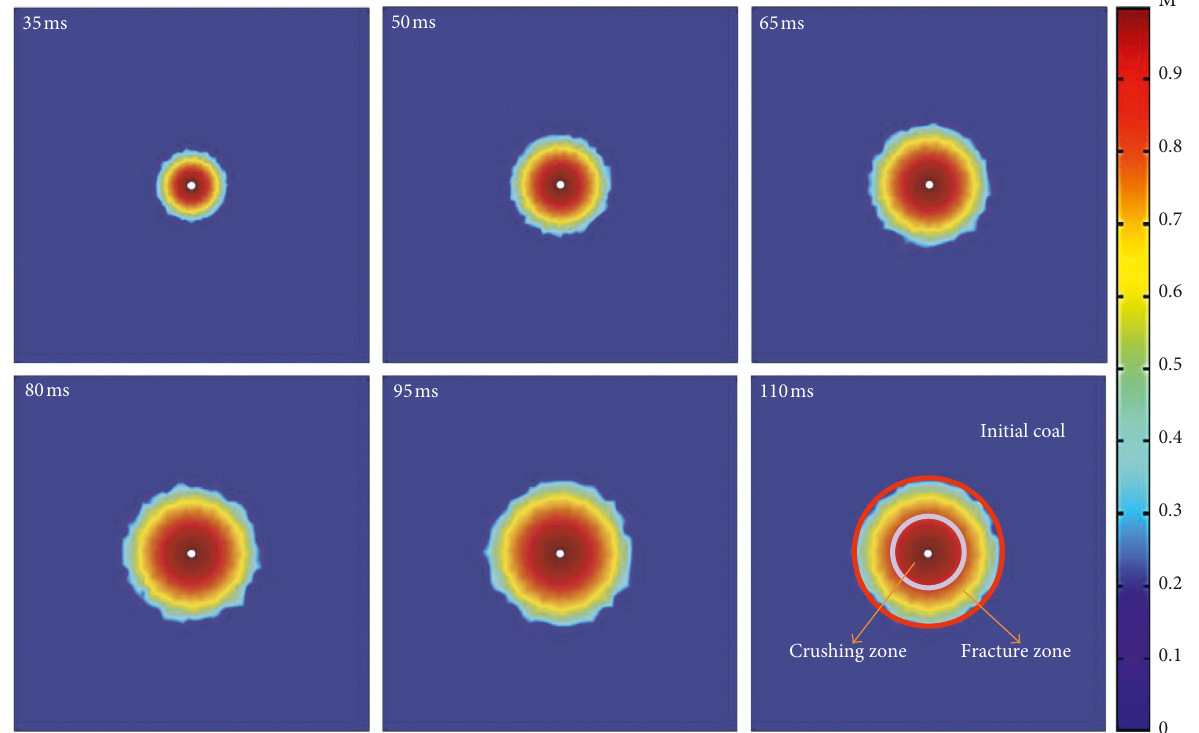
Figure 10: Expansion of damage zone over time.